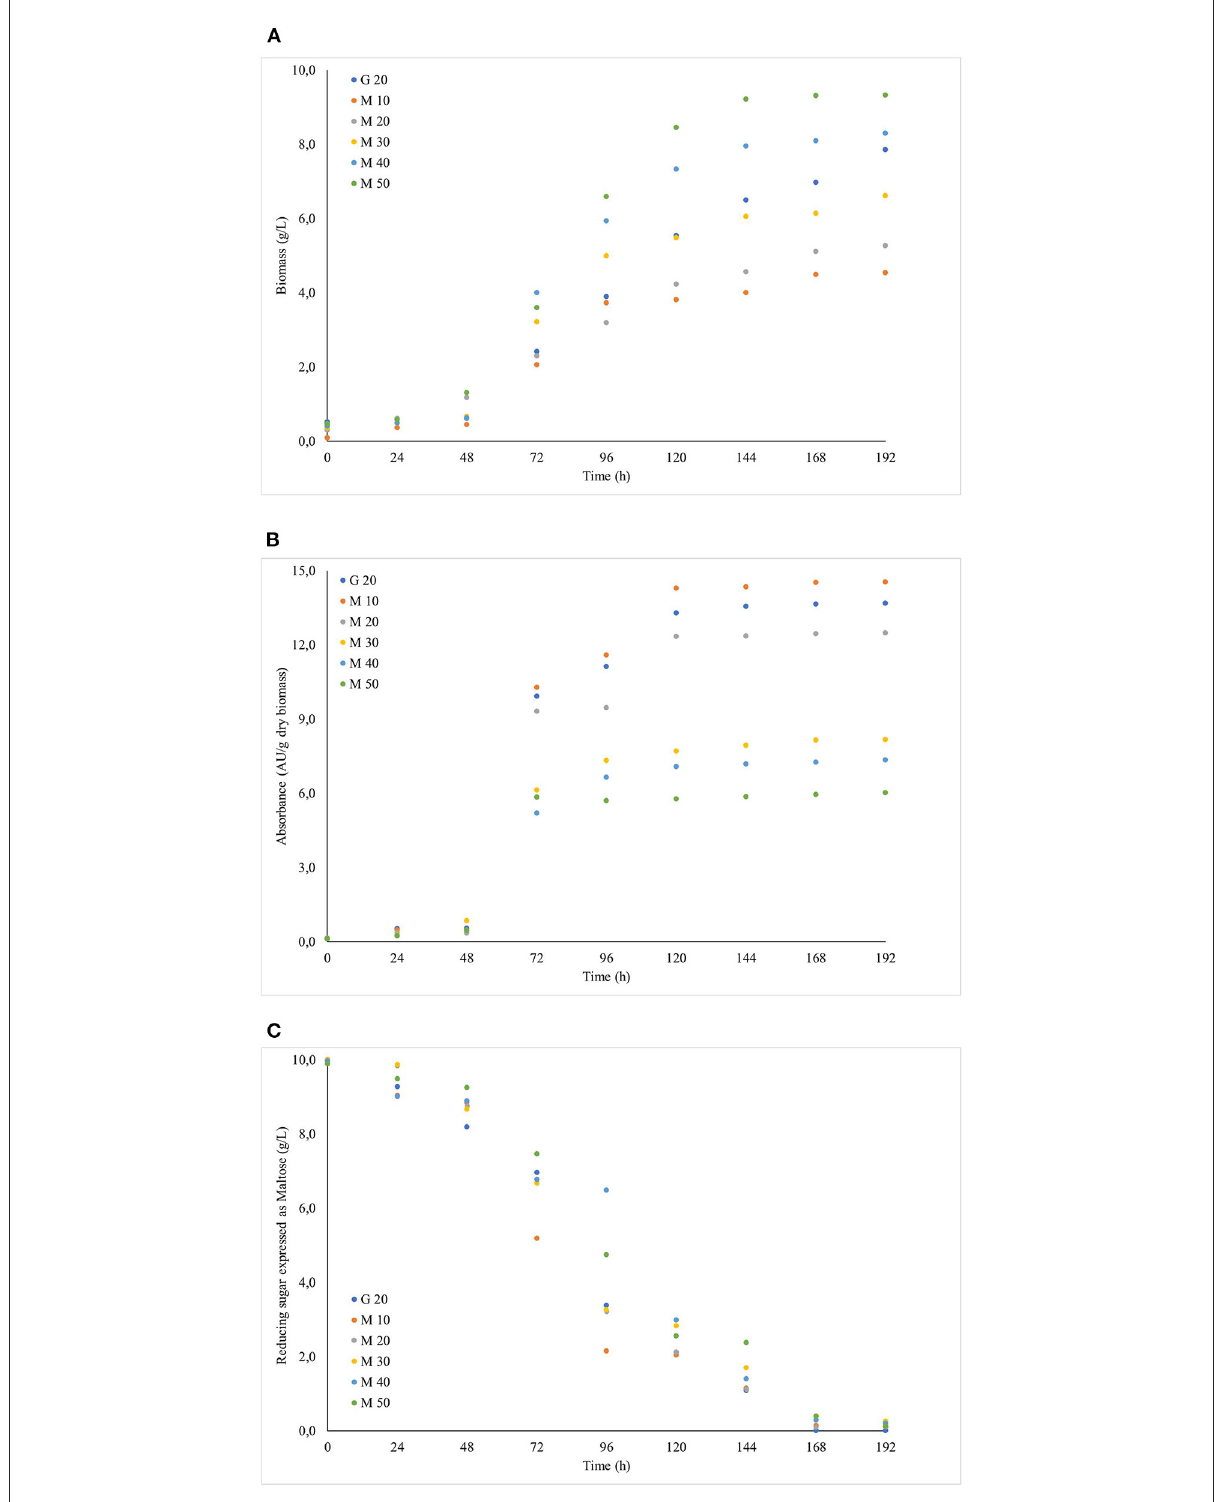
FIGURE4 Evolution of the cultivation of Monascus ruber CCT 3802 grown in different concentrations of maltose syrup: (A) Biomass, (B) Reducing sugar and (C) Absorbance units.